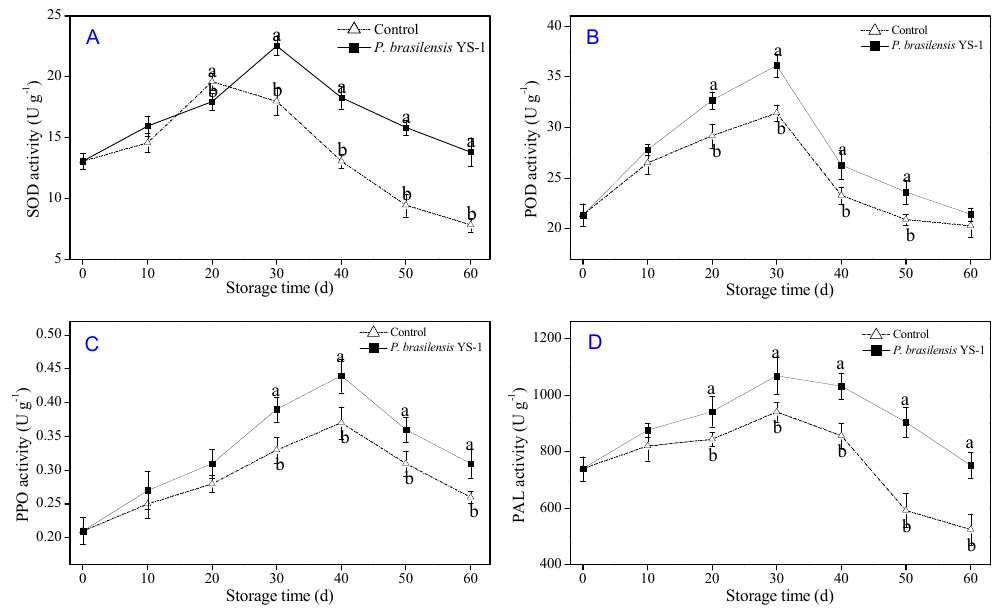
Figure 5. Effects of P. brasilensis YS-1 treatment on SOD ( A ), POD ( B ), PPO ( C ) and PAL ( D ) activities of citrus fruits stored at 5 ± 0.5 °C for 60 days. Vertical bars represent the mean ± SE ( n = 3). Letters indicate statistical differences according to an independent samples t -test ( p < 0.05) on each storage day.